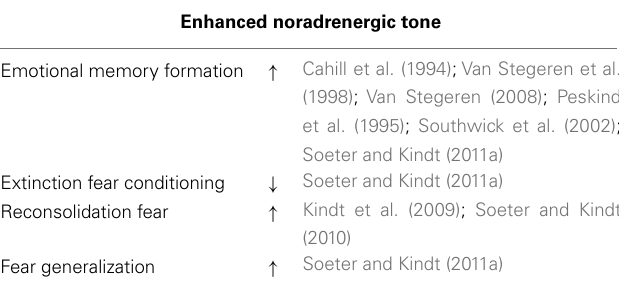
Table 1 | Role noradrenergic hormones in emotional